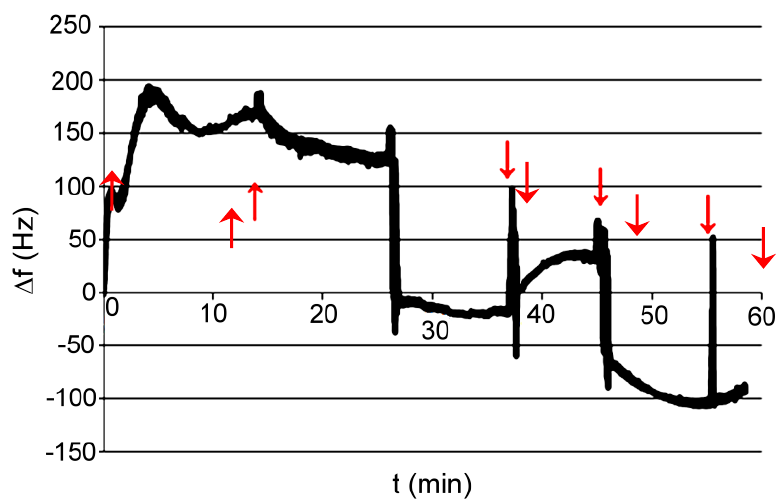
Figure 12. Changes of frequency in time for AP I polymer; absorbed compound—acetylsalicylic acid in ethanol.